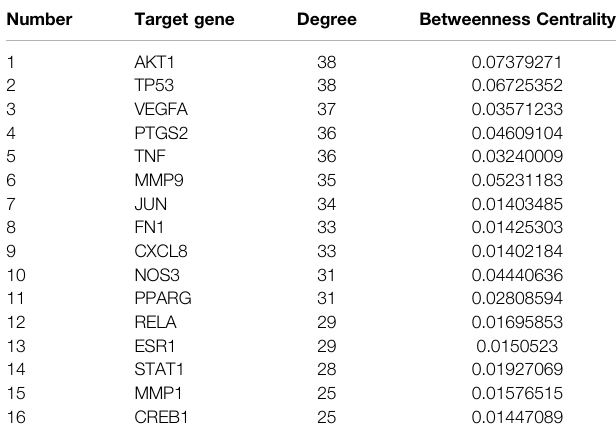
TABLE 2 | The core targets of TW in the treatment of DN.